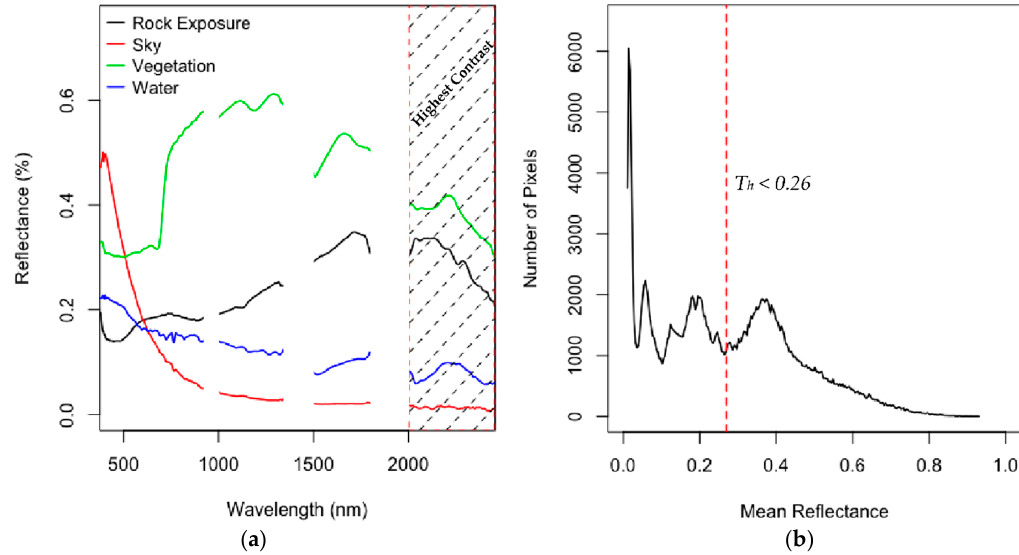
Figure 4. ( a ) Representative spectra of end-members collected from the reflectance hyperspectral image for the rock exposure, sky, vegetation, and water. The red box indicates the wavelength range of the highest spectral contrast (i.e., 2004–2453 nm) between the selected end-members. Water and sky spectra show lower reflectance values (<0.1) as compared to vegetation and rock exposure end-members (>0.2). ( b ) Histogram plot of the mean reflectance values over the wavelength range selected in a) for all the pixels. The dotted red line indicates the selected masking threshold to differentiate the rock exposure and vegetation from sky and water pixels.